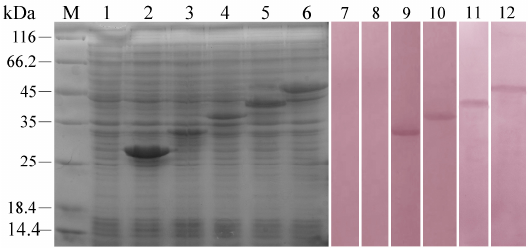
Figure 1. Detection of the binding specificity of rFc β Int-ER to five WSSV envelope proteins by far-western assay. Lane M, molecular weight protein marker; Lane 1–6: The uninduced bacteria lysate and five recombinant envelope proteins stained by Coomassie Brilliant blue. Lane 7–12: Western blotting of five recombinant envelope proteins on PVDF membranes. Lane 1 and 7: Negative controls using the uninduced bacteria lysate; lane 2 and 8: rVP28; lane 3 and 9: rVP31; lane 4 and 10: rVP37; lane 5 and 11: rVP110; lane 6 and 12: rVP187.